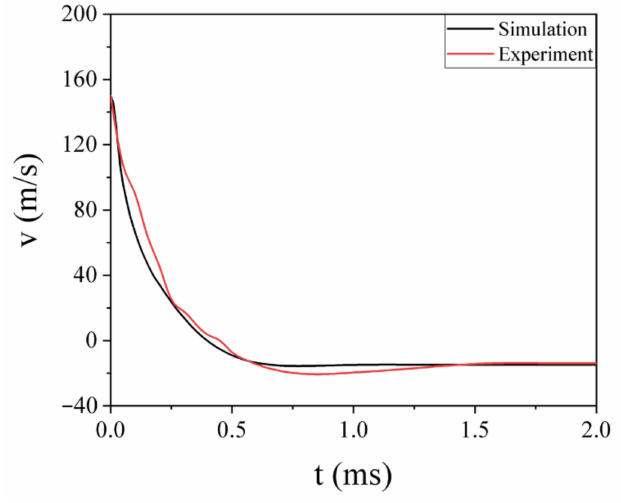
Figure 9. Comparison between the simulation and experiment of the velocity of the projectile.